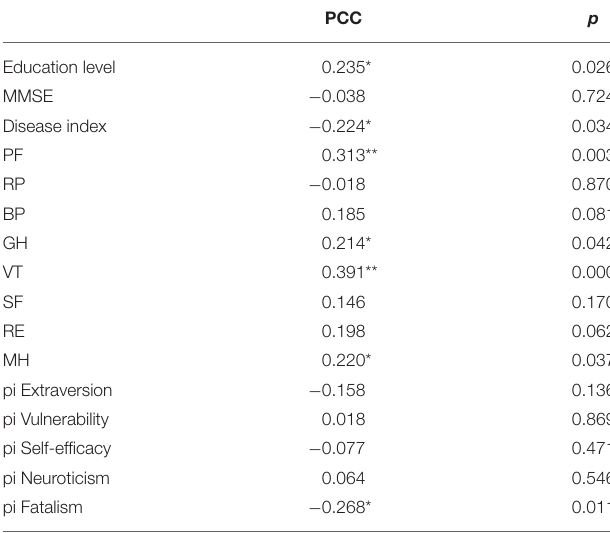
TABLE 7 | Correlation between attendance and baseline